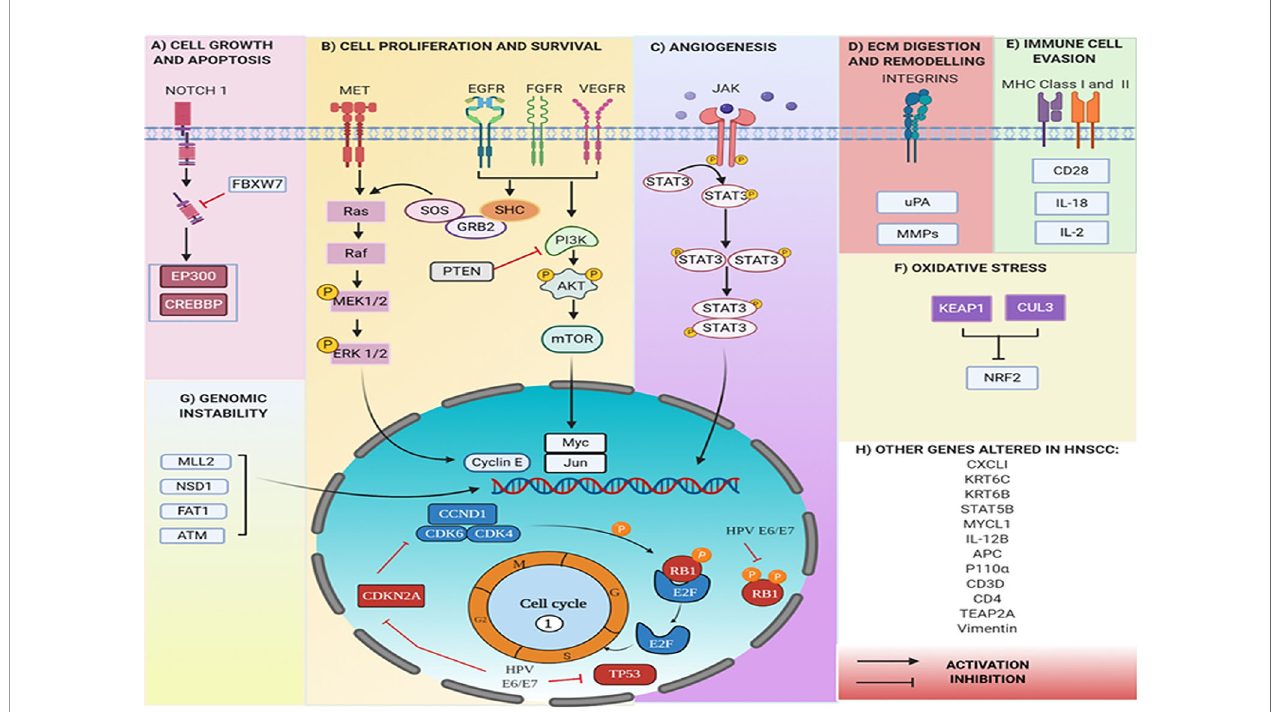
FIGURE 4 | Genes altered in HNC at genomic and transcript levels. (A) Mutations in NOTCH gene pathway leads to cell growth and evasion of apoptosis, whereas (B) in RTKs ( VEGFR, EGFR, FGFR ) lead to alterations through RAS/RAF/MAPK pathway or PI3K/AKT/mTOR axis, eventually leading to uncontrolled cell proliferation, (C) in JAK/STAT pathway increase angiogenesis. (D) The integrins ( ITGA 3 and ITGA 5 ), uPA , and MMP 1,2,3,9.10,13 are all involved in ECM digestion and remodeling. (E) MHC I and MHC II expression is altered to evade recognition by immune cells. (F) Oxidative stress is increased due to mutations in genes like NRF2, whereas (G) mutations in NSD1, MLL2, ATM are characteristic of genomic instability. HPV proteins E6 and E7 inhibit TP53 and RB1 . All eventually leading to uncontrolled cell proliferation and (H) , multiple other genes are altered, producing signi fi cant